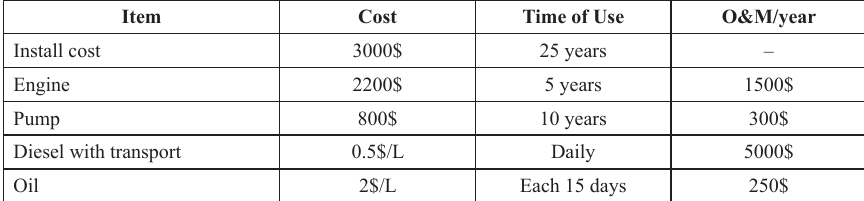
Table 1. Cost of diesel pump operation